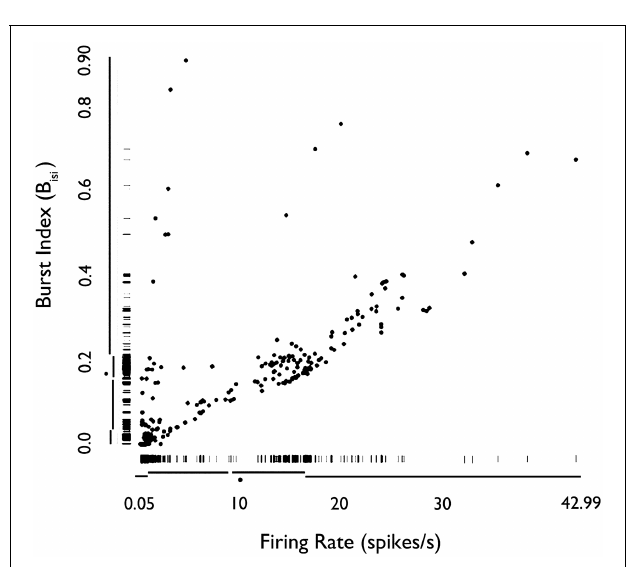
FIGURE 3 | Rug plot of mean firing rate of HH neurons versus burst index ( B isi ) . Fast-firing units (mean firing rate > 2sp/s) scored higher on the burst index. Conversely, slow-firing units (mean firing rate < 2sp/s) were associated with lower scores on the burst index. However, units with relatively slow-firing features and bursting tendencies were also observed. Used with permission from Barrow Neurological Institute.